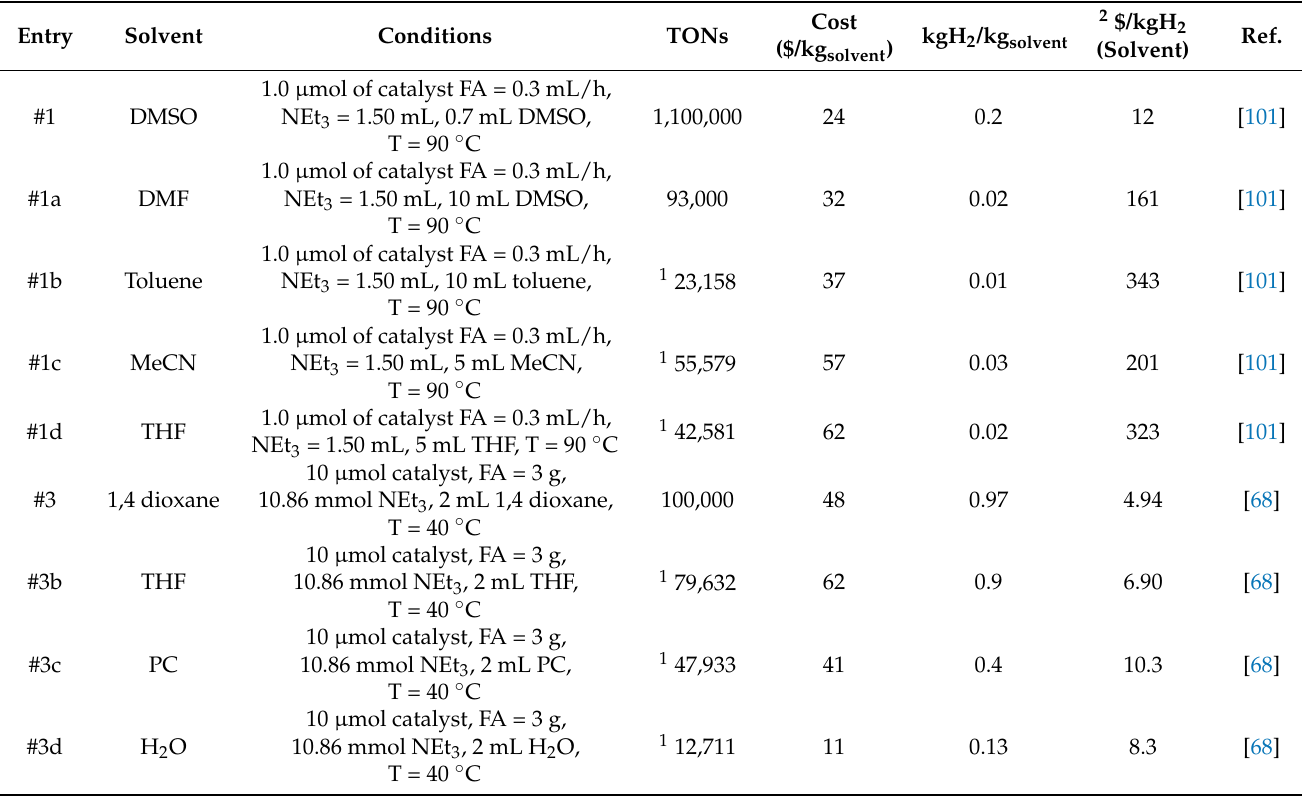
Table 4. Cost analysis based on the